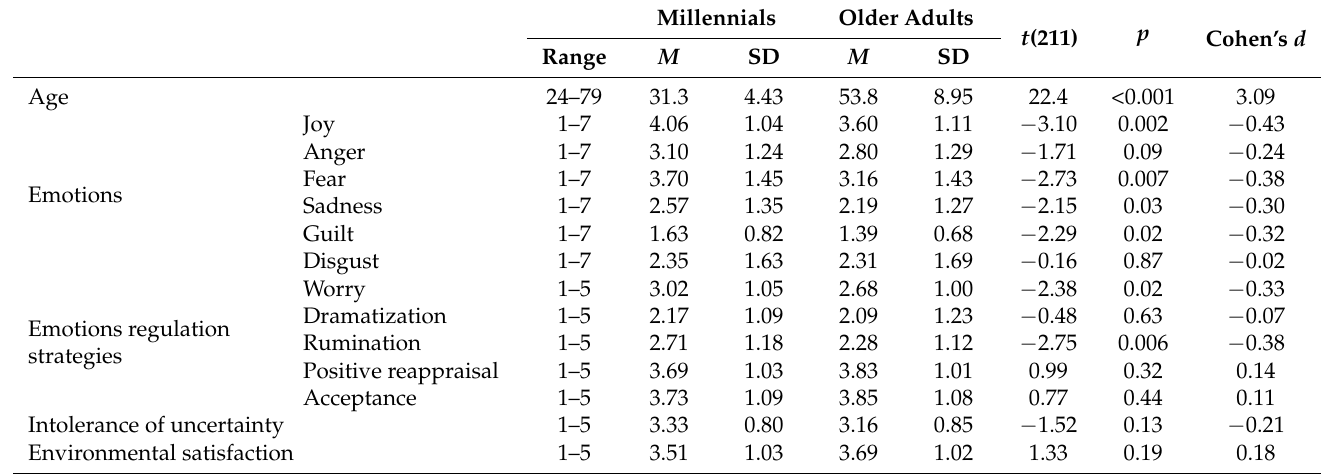
Table 2. Results of generations’ comparisons through independent t